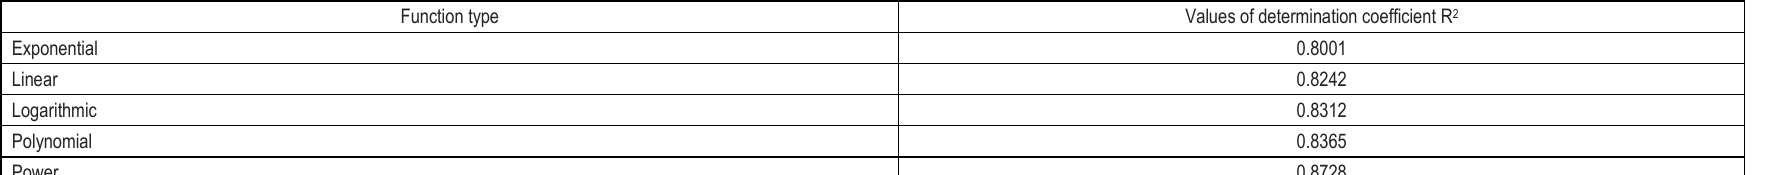
Table В.3 . Interim calculations to determine the type of growth curve for the volume of gross insurance premiums in 2005 – 2015